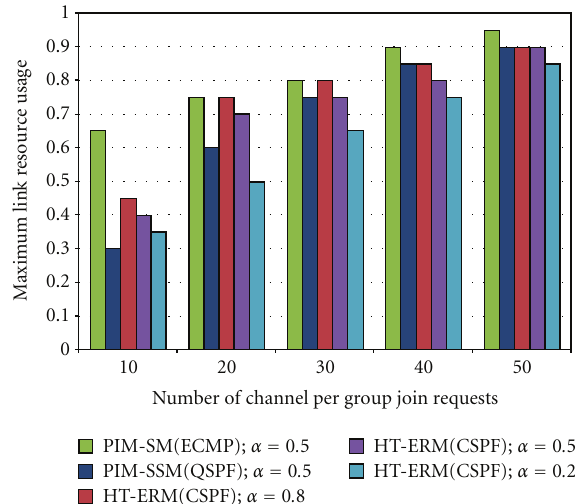
Figure 11: Comparisons of resource usage for IPTV